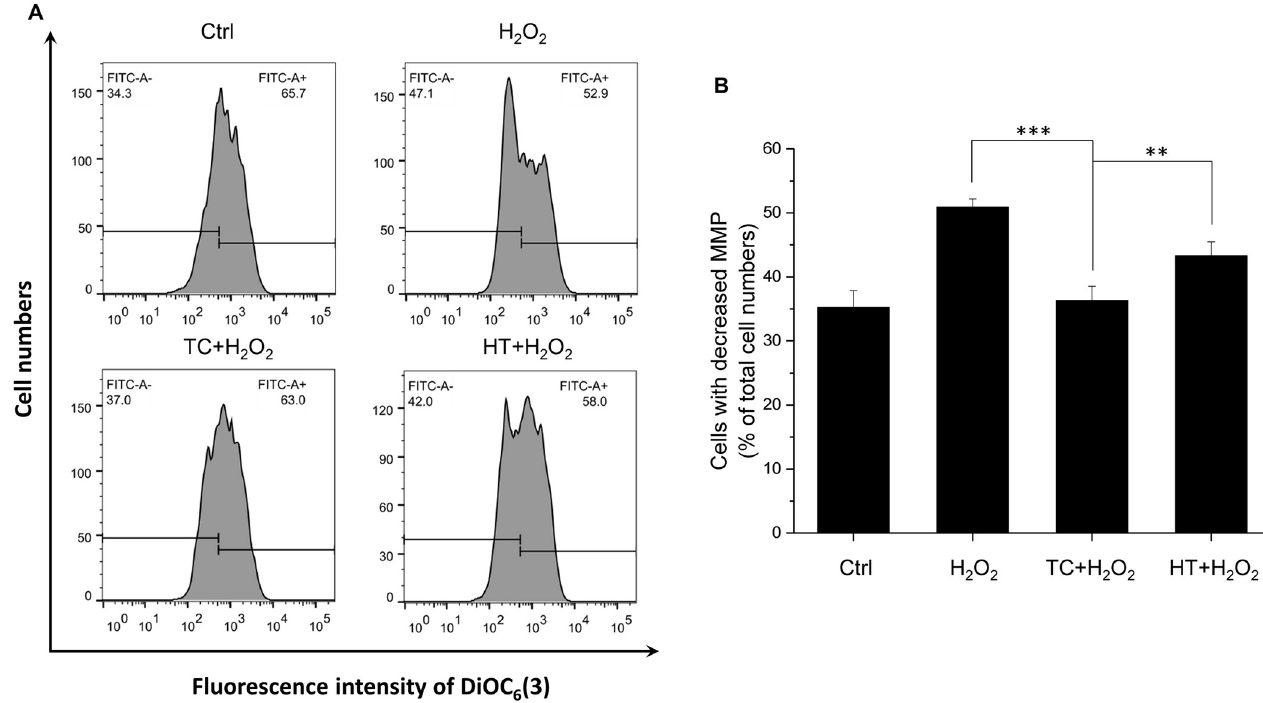
Fig 5. Effect of TC-HT on H 2 O 2 -induced MMP reduction in SH-SY5Y cells. (A) MMP was analyzed 24 h after the H 2 O 2 treatment by flow cytometry with DiOC 6 (3) fluorescent dye. (B) Quantification of the cells with decreased MMP after H 2 O 2 , TC+H 2 O 2 , or HT+H 2 O 2 treatment. Data represent the mean ± standard deviation (n = 3). ��� P < 0.001 and �� P < 0.01.